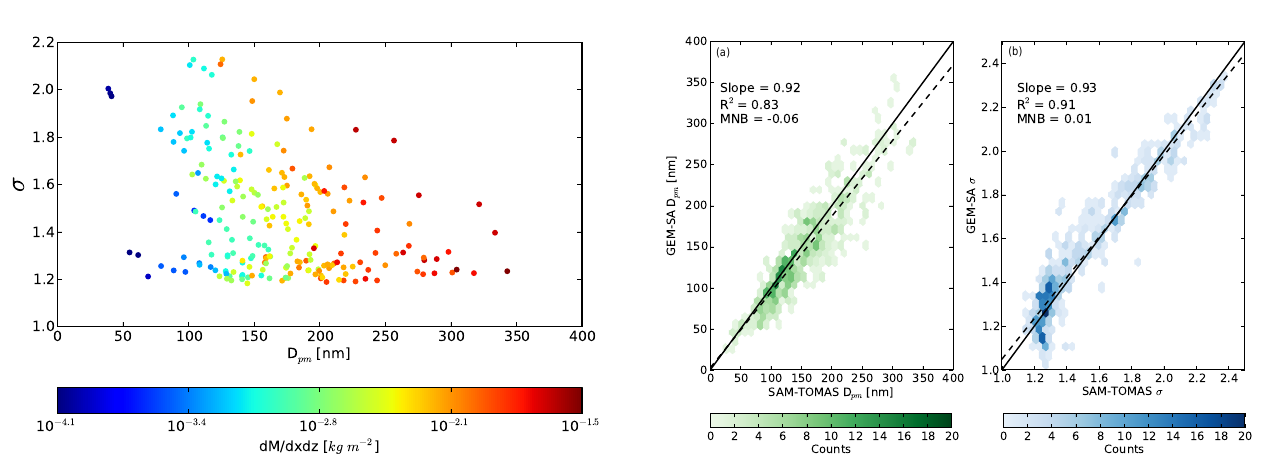
Figure 5. Scatterplot showing the relationships between final modal width ( σ) , final D pm , and d M/ d x d z for each of the SAM-TOMAS simulation slices at distances greater than 25km from the fire.